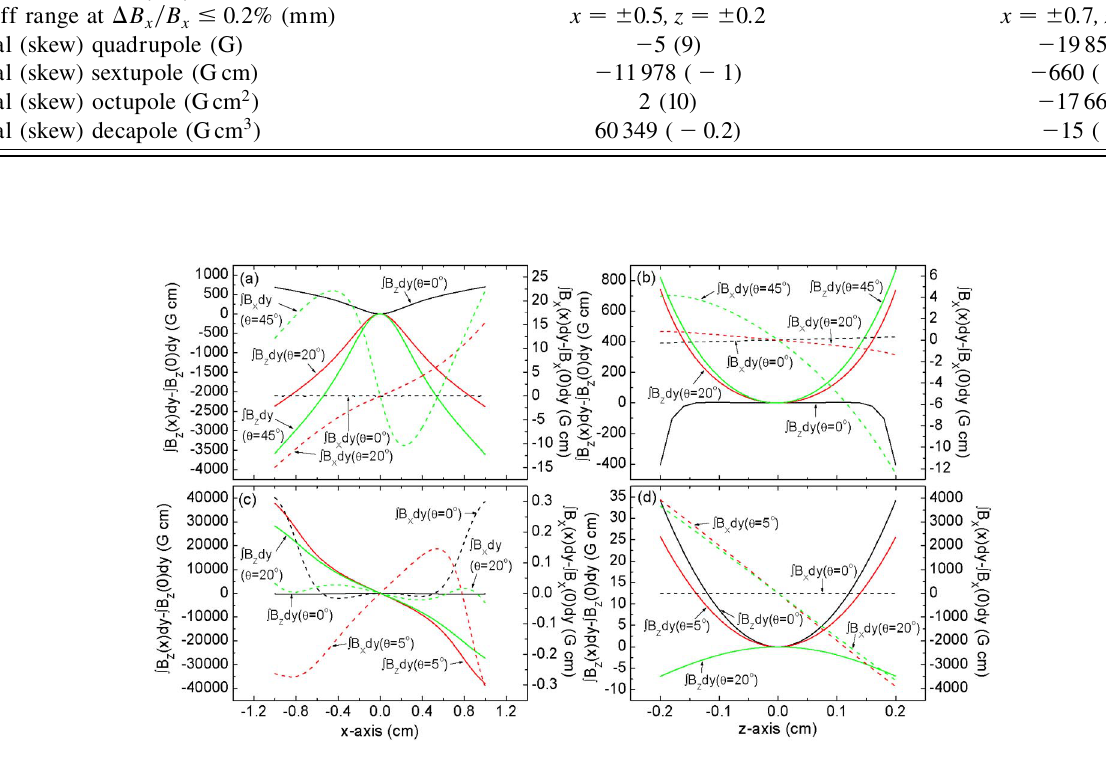
TABLE II. Magnetic field features of a superconducting elliptical undulator in a racetrack coil and staggered undulators in which wires and poles are rotated by 20 (cid:2) and 5 (cid:2) , respectively; the multipole components were analyzed on the transverse x axis (cid:10) 10 mm . Racetrack coil Staggered (cid:11) 0 : 2% (mm) =B Roll-off range at (cid:17) B z z